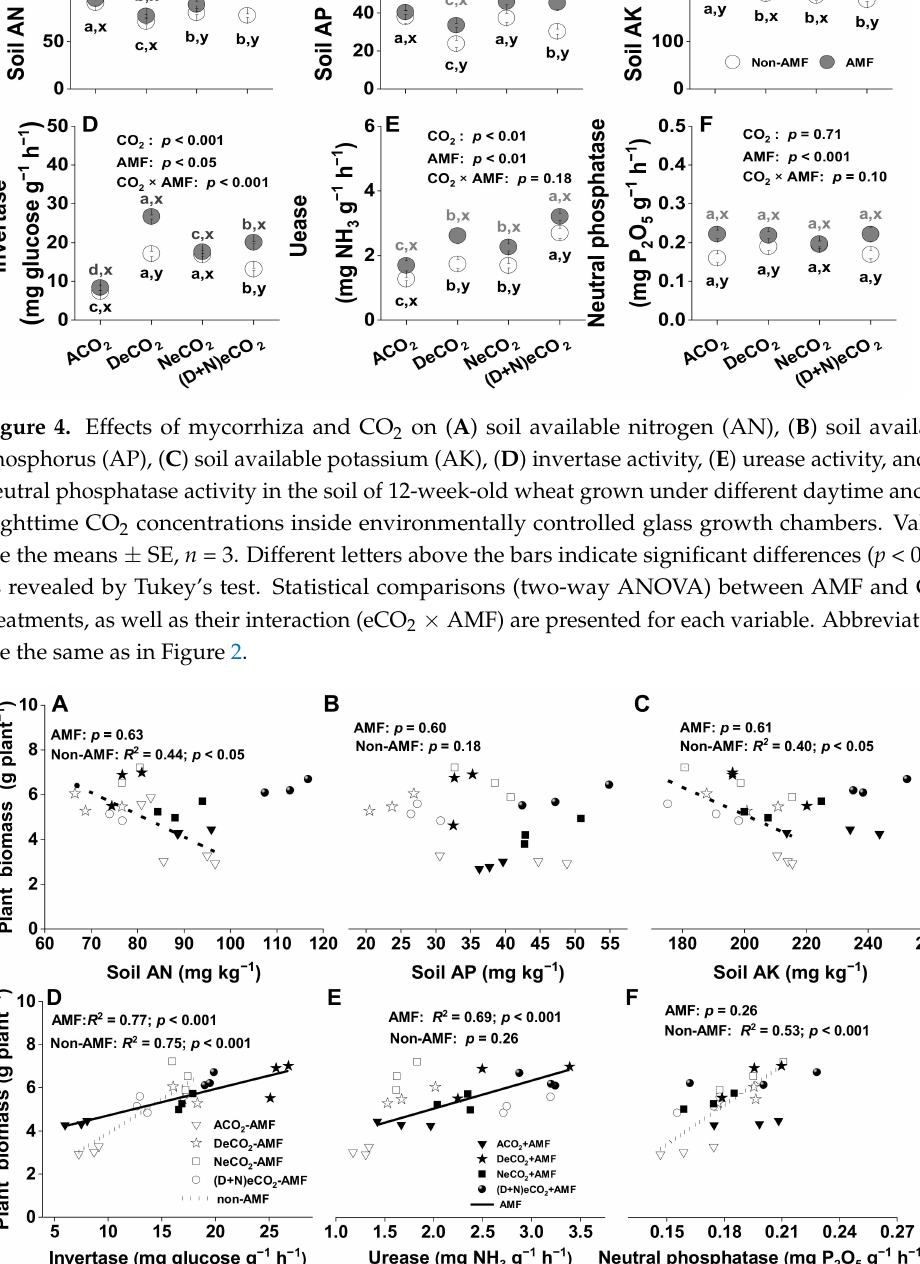
Figure 5. Relationships between plant biomass production and ( A ) soil available nitrogen (AN), ( B ) soil available phosphorus (AP), ( C ) soil available potassium (AK), ( D ) soil invertase, ( E ) urease or ( F ) neutral phosphatase in the soil of 12-week-old wheat grown under different daytime and/or nighttime CO 2 concentrations inside environmentally controlled glass growth chambers. Data are means ± SE, n = 12. Regressions are shown for non-AMF (dotted lines) and for AMF (solid lines) treatments. Abbreviations are the same as in Figure